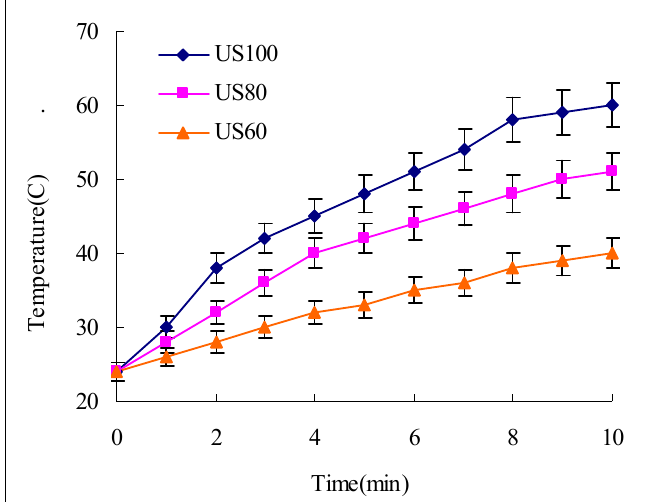
Figure 1. Temperature alteration of ultrasound wheat gluten suspensions as a function of